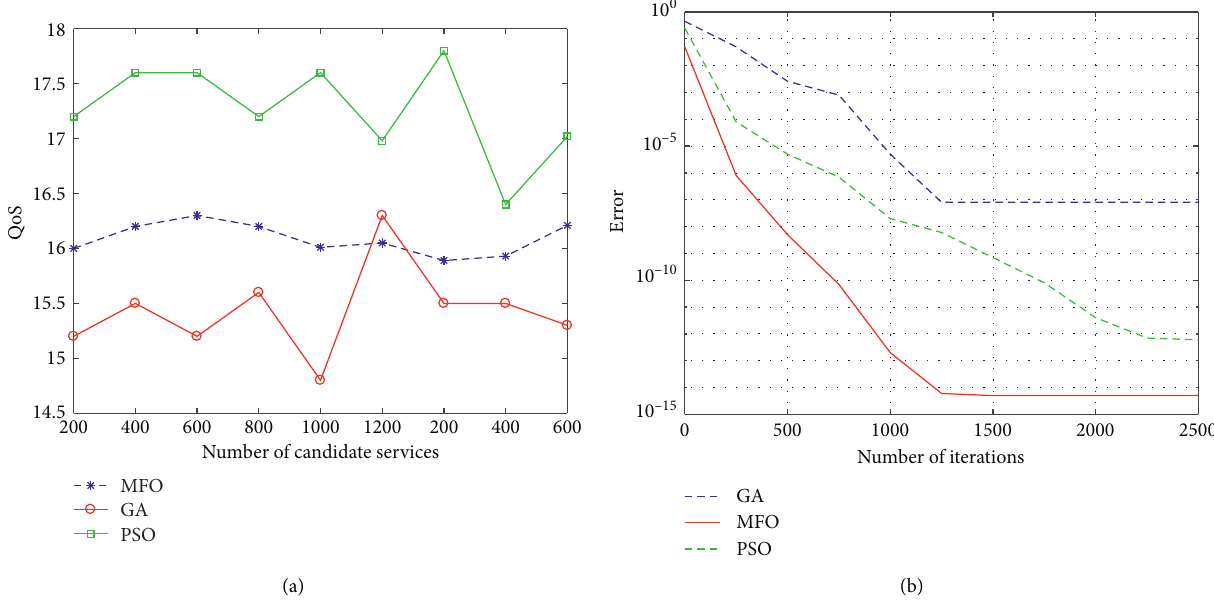
Figure 5: Relationship between QoS and number of services. (a) QoS changes with the number of candidates; (b) error change with the number of iterations.